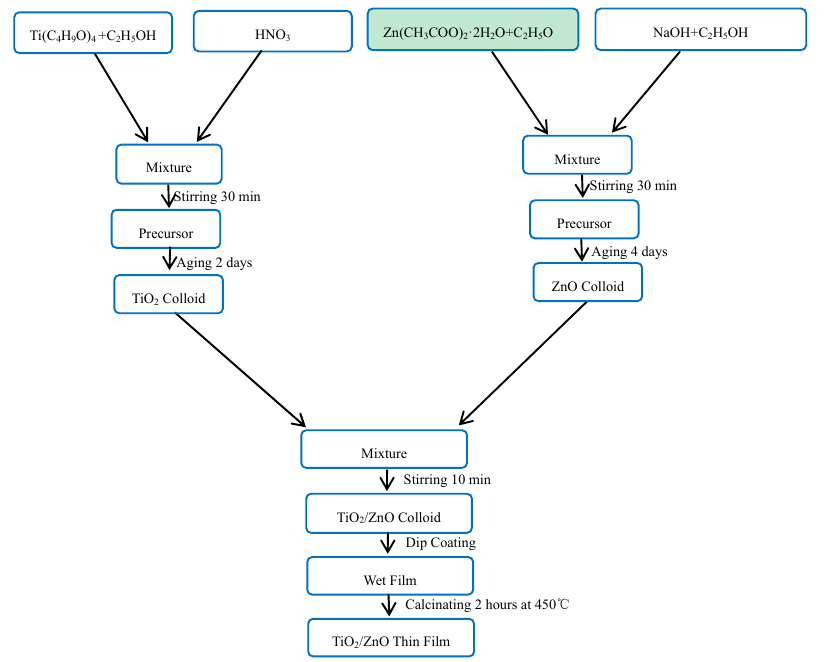
Figure 2. Flow chart of composite TiO 2 /ZnO film preparation.